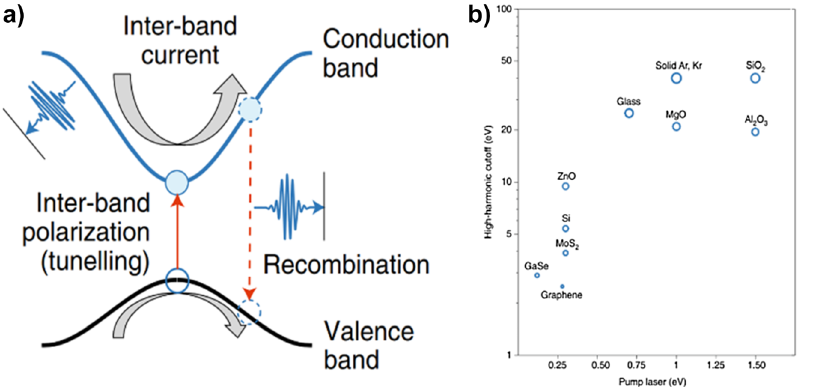
Figure 10: HHG in solids. (a) Mechanism of HHG in solids: momentum-space interpretation. Under strong field conditions, electrons in the solids ascend from the valence band to the conduction band by tunneling effect. Electron – hole pairs are accelerated along with the vector potential, and the intrabandHHGisattributedtotheinterbandcurrentintheconductionband,whereastheinterbandHHGdependsontheelectronrecombining with its left-behind hole (interband recombination). (b) HHG in various solid materials. The high harmonic cut-off depends on the band structureofthesolidandthewavelengthofthepumplaser.Thelargebandgapdielectricmaterialsenablehigher-order harmonicsbecauseof the high damage threshold at a short wavelength, whereas the narrow bandgap materials such as semiconductors or 2D materials require a relatively longer wavelength for the HHG to develop